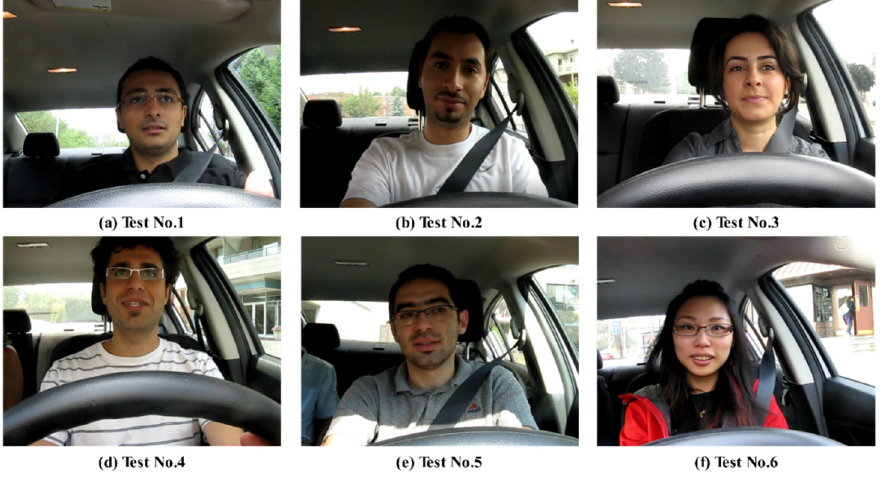
Figure 15. Test video number.